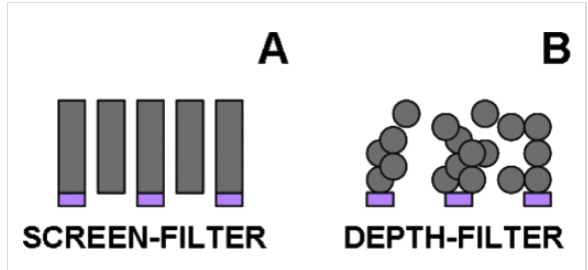
Figure 7: Schematic cross section of a screen filter (A) and a depth filter (B). Reprinted with permission from [4], copyright 2017 Elsevier.